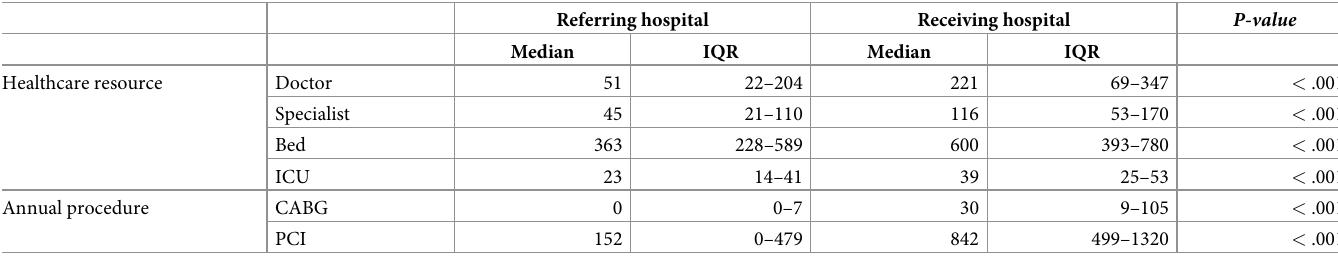
Table 5. Resources and volume of care in the referring and receiving hospitals where the transferred patients with acute myocardial infarction